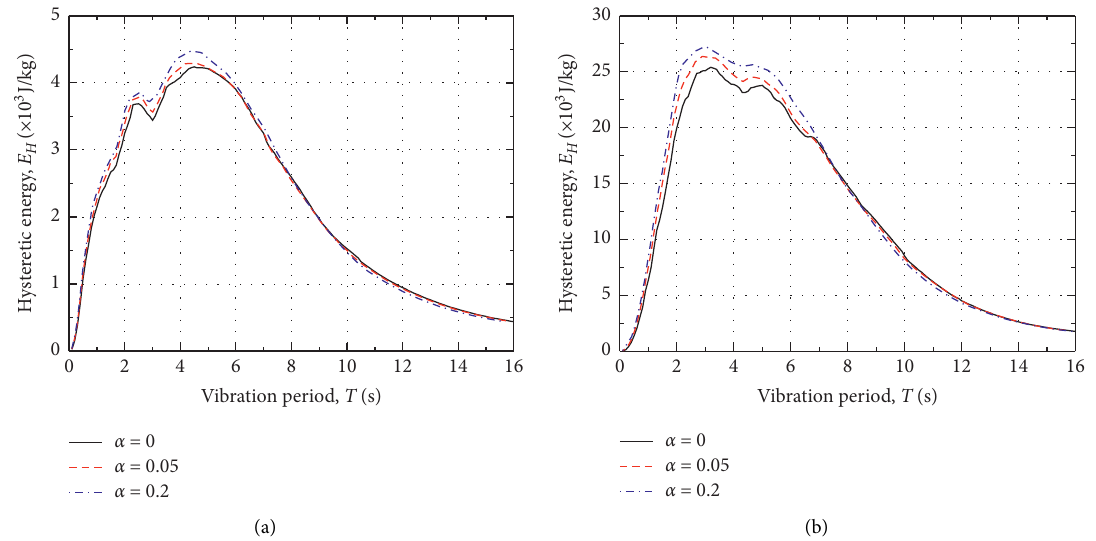
Figure 17: Hysteretic energy spectra affected by yield stiffness ratio. (a) Near-fault pulse-like ground motions. (b) Far-field harmonic ground